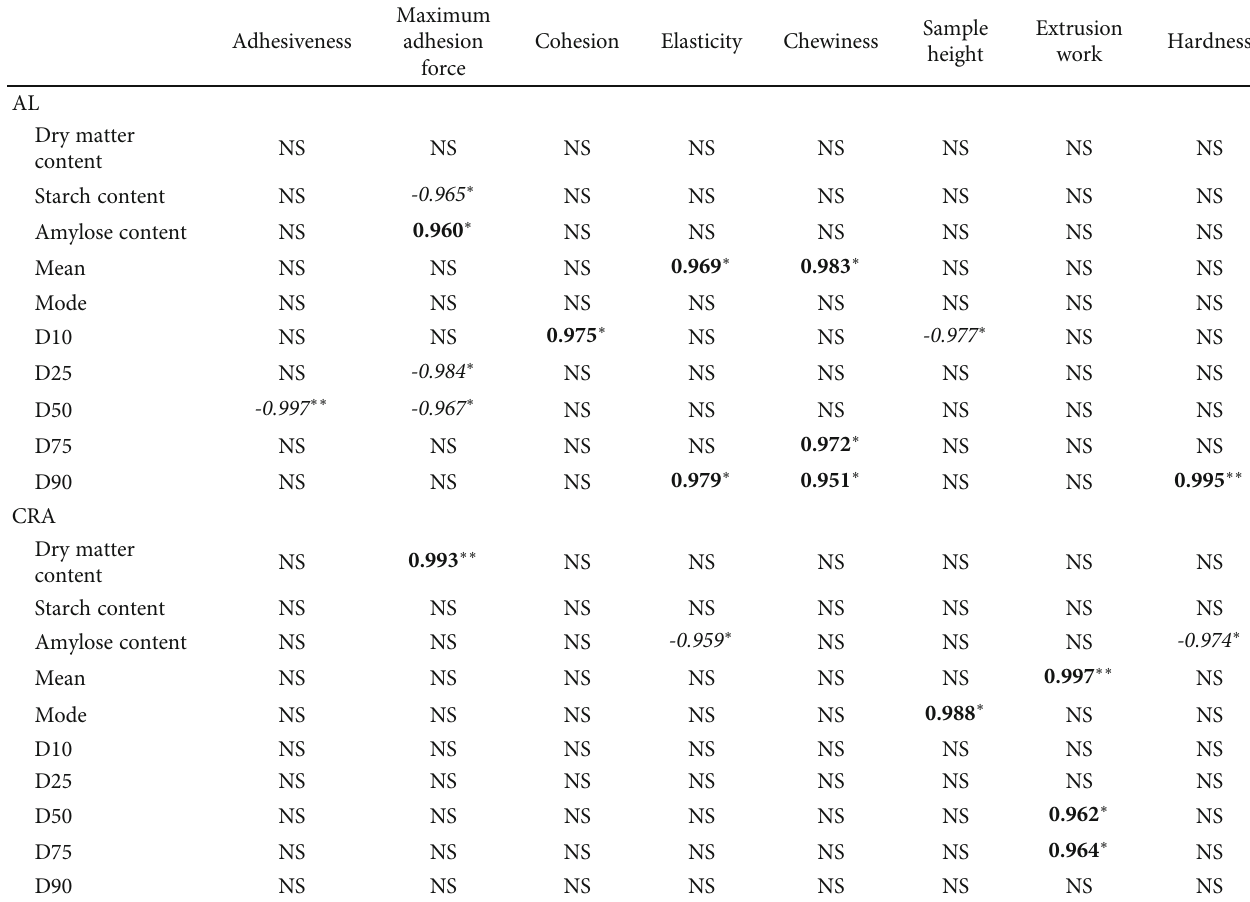
Table 1: Relevance analysis